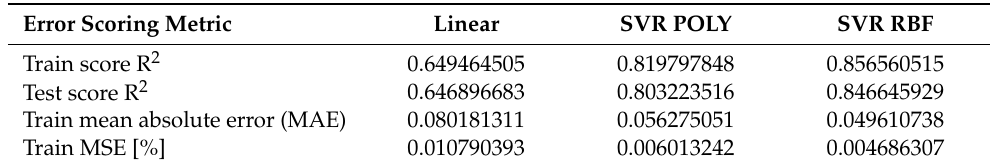
Table 3. Model error scoring comparison with ε = 0.1, C =